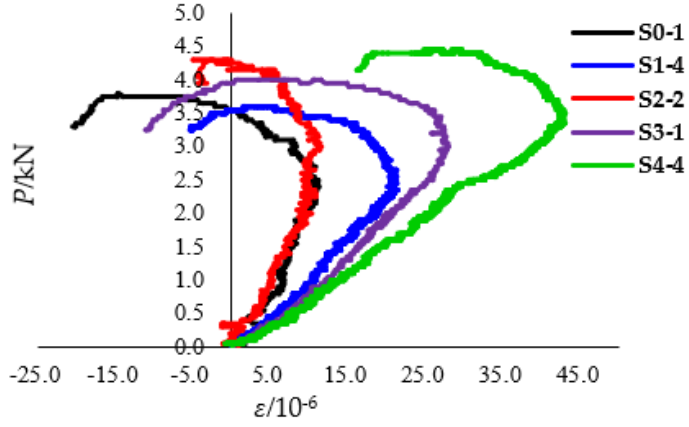
Figure 6: P- ε curves of some